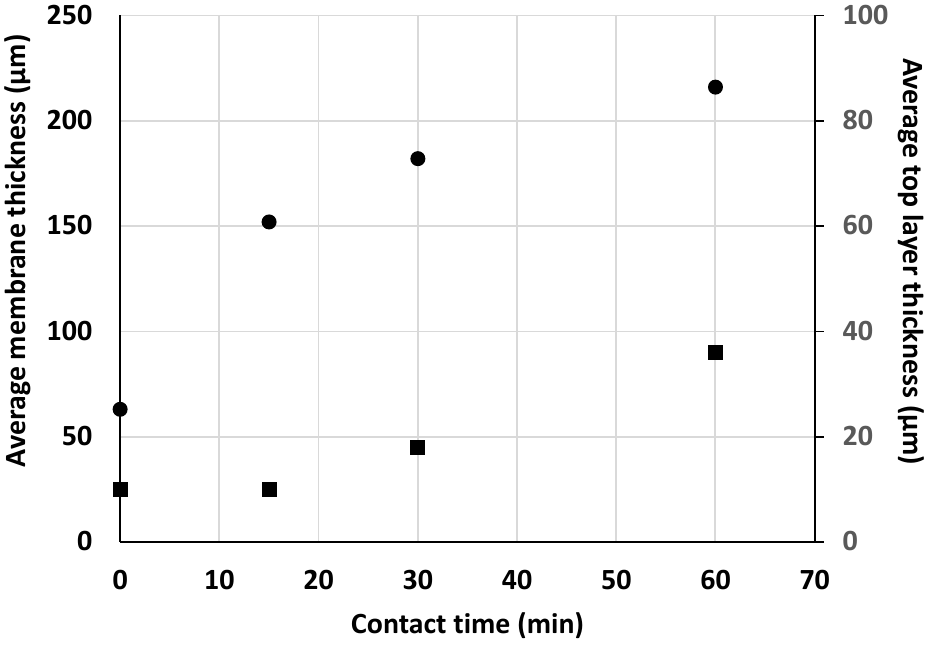
Figure 3. Variation of the average membrane ( • ) and top layer ( (cid:4) ) thickness after 0, 15, 30 and 60 min reaction time with STPP.